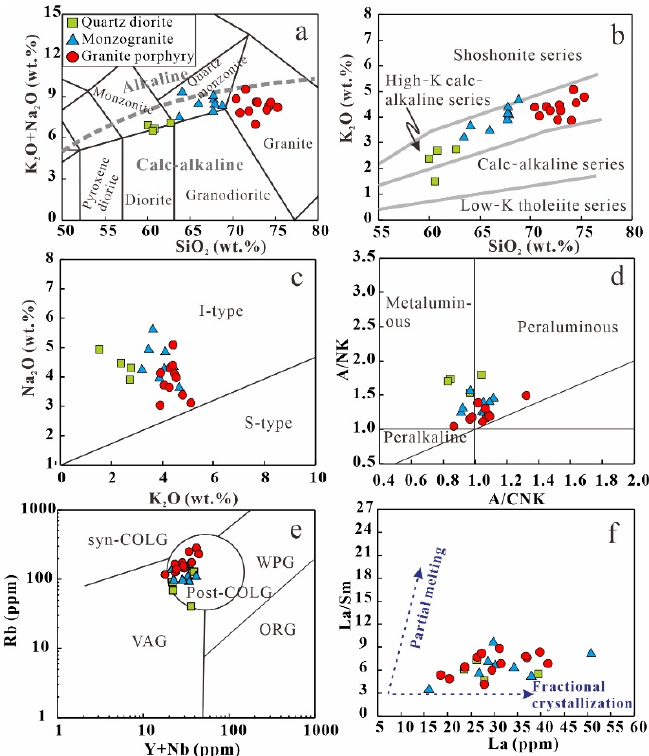
Figure 6. Selected discrimination diagrams for the granitoids from Zalute. ( a ) Total alkalis versus silica classification [61]; ( b ) SiO 2 versus K 2 O [62]; ( c ) Na 2 O versus K 2 O [63]; ( d ) A / NK (molar Al 2 O 3 / (Na 2 O + K 2 O)) versus A / CNK (molar Al 2 O 3 / (CaO + Na 2 O + K 2 O)) [64]; ( e ) Rb versus (Y + Nb) [65]; and ( f ) La / Sm versus La diagrams [66]. WPG: within-plate granite; VAG: volcanic arc granite; Syn COLG: syn-collisional granite; Post-COLG: post-collisional granite; and ORG: ocean ridge granite.